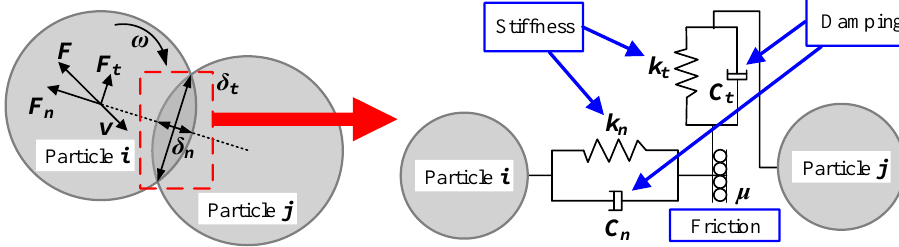
Figure 11. Schematic diagram of the Hertz – Mindlin contact model.